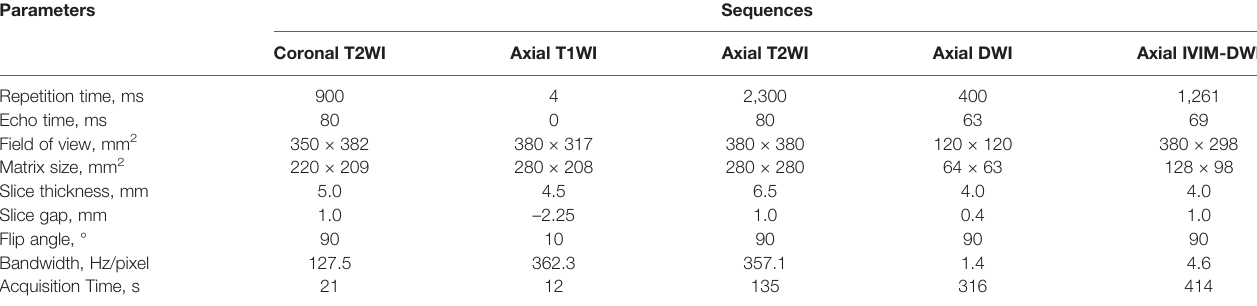
TABLE 1 | Magnetic resonance imaging parameters.